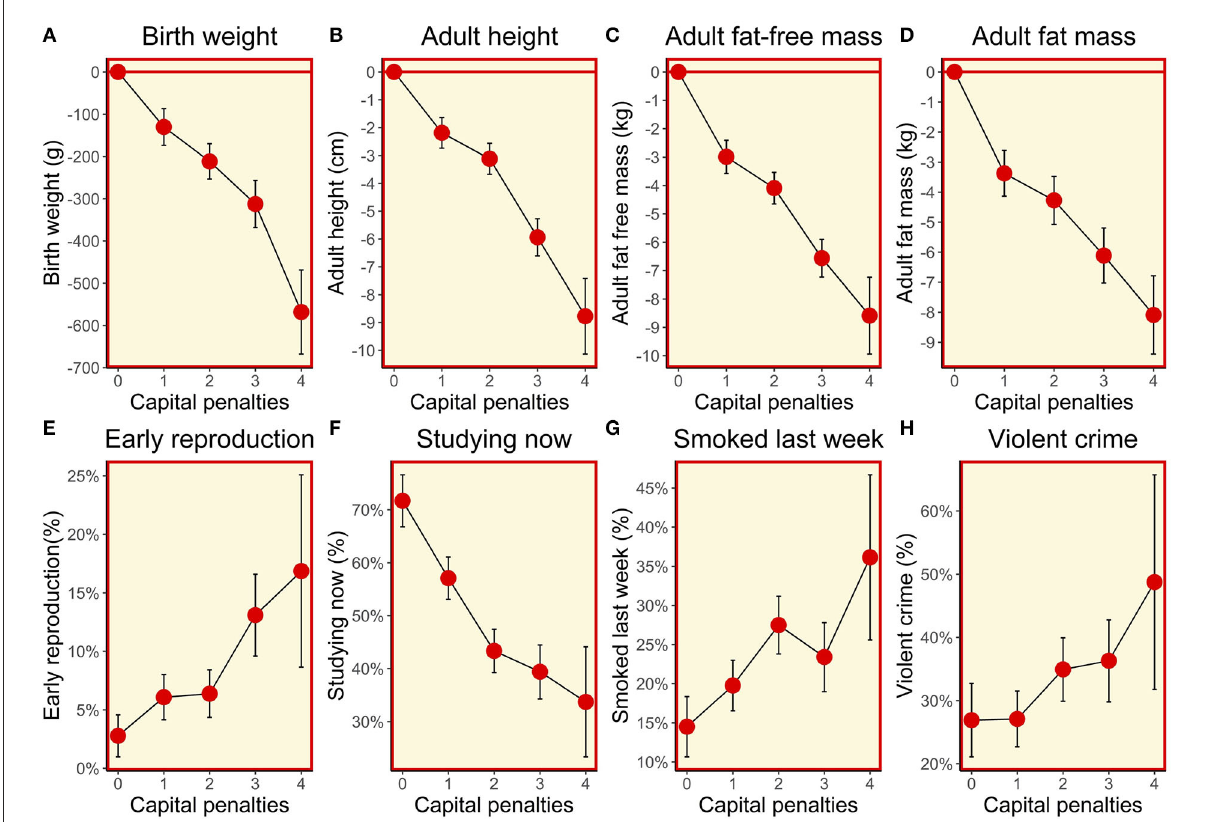
FIGURE5 (A–H) Dose-response associations between sons’ traits and the magnitude of maternal capital, categorised in terms of a total composite score of “penalties” (ranging from 0 to 4) selected from the categories “short stature”, “low body mass index”, “low education” and “low family income”. See text for details of how the index and its categories are